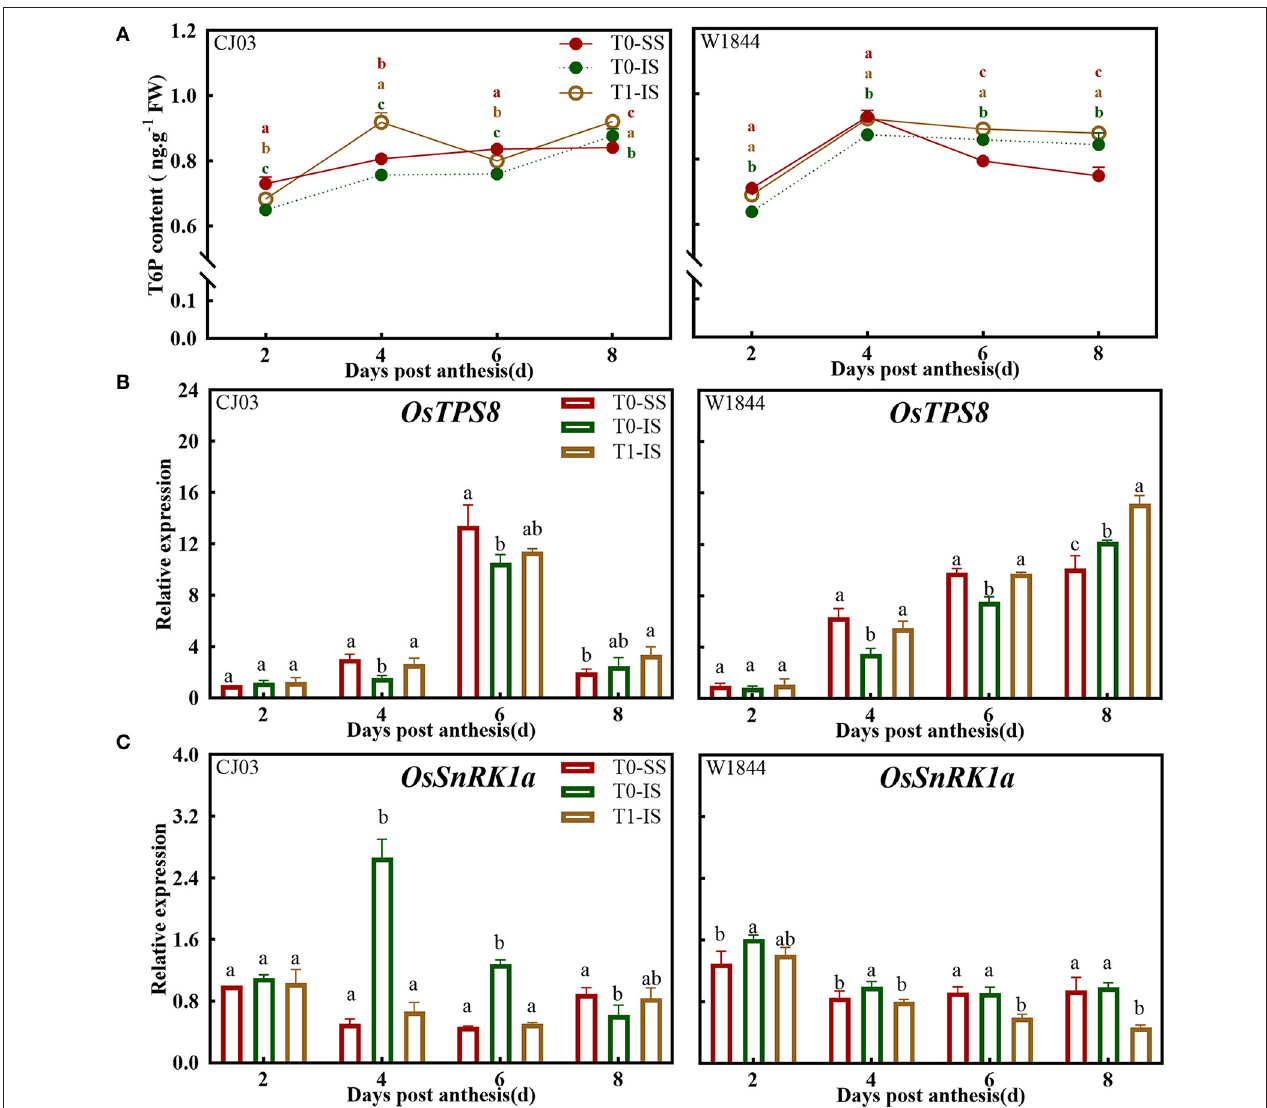
FIGURE 8 | T6P and SnRK1 levels in developing grains of CJ03 and W1844 under spikelet-removing treatment. The T0-control group without any treatment; T1- top 2/3 of the spikelets were removed. Red, green, and yellow bars represent the SS of the T0 group, the IS of the T0 group, and the IS of the T1 group. (A) , T6P content in developing grains at the initiation stage of grain-filling. (B) , the expression of OsTPS8 was validated by RT-PCR. (C) , the expression of OsSnRK1a was validated by RT-PCR. Colored letters indicate statistically significant differences at the P = 0.05